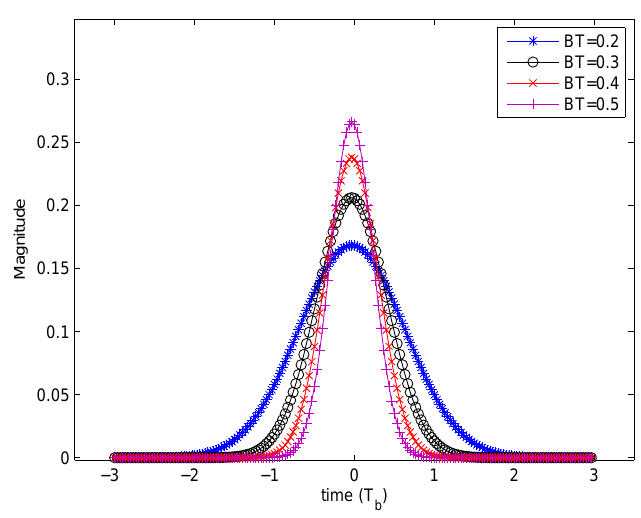
Figure 2. The Gaussian pulse waveform with different BTs.